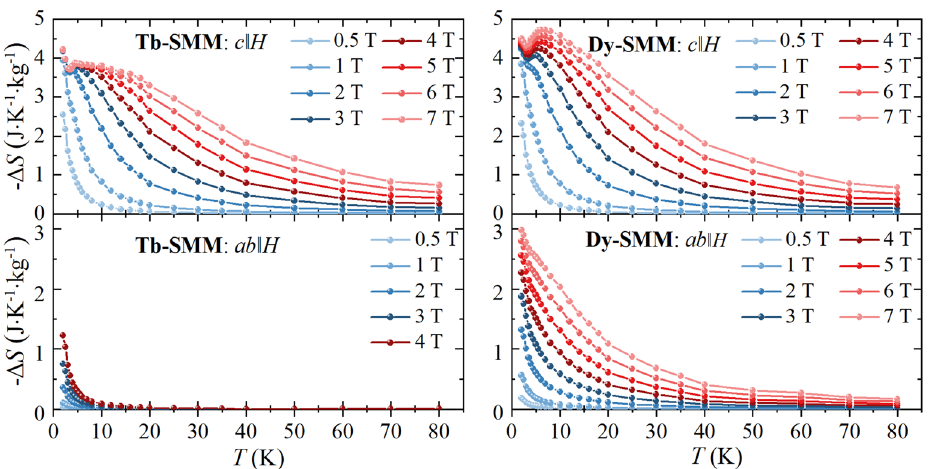
Figure 4. The temperature dependence of entropy change − Δ S ( T , H ) for various magnetic field changes for Tb-SMM and Dy-SMM estimated for the c ∥ H and ab ∥ H orientations. Solid lines are guides for the